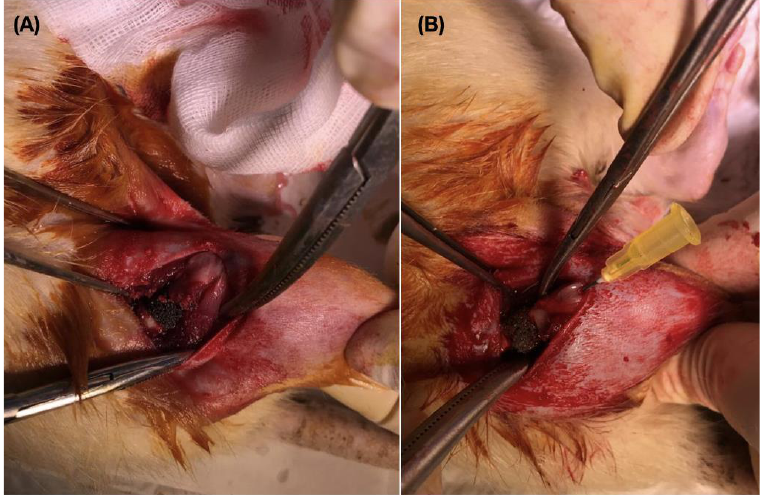
Figure 1. ( A ) 5 mm large femoral defect filled with a porous scaffold. ( B ) Retrograde intramedullary pin fixation.